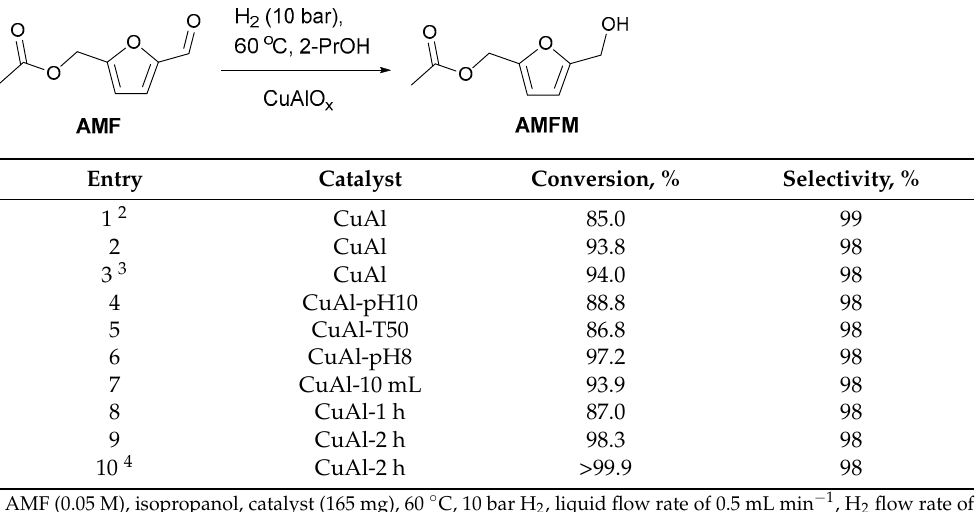
Table 4. AMF hydrogenation over CuAlO x catalysts in a flow reactor 1 .